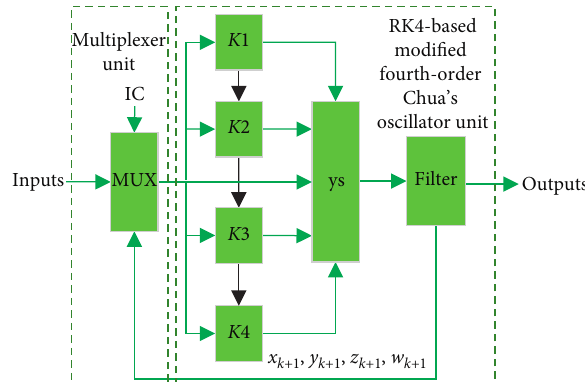
Figure 14: The block diagram of the FPGA-based multistable modified Chua’s chaotic oscillator unit.